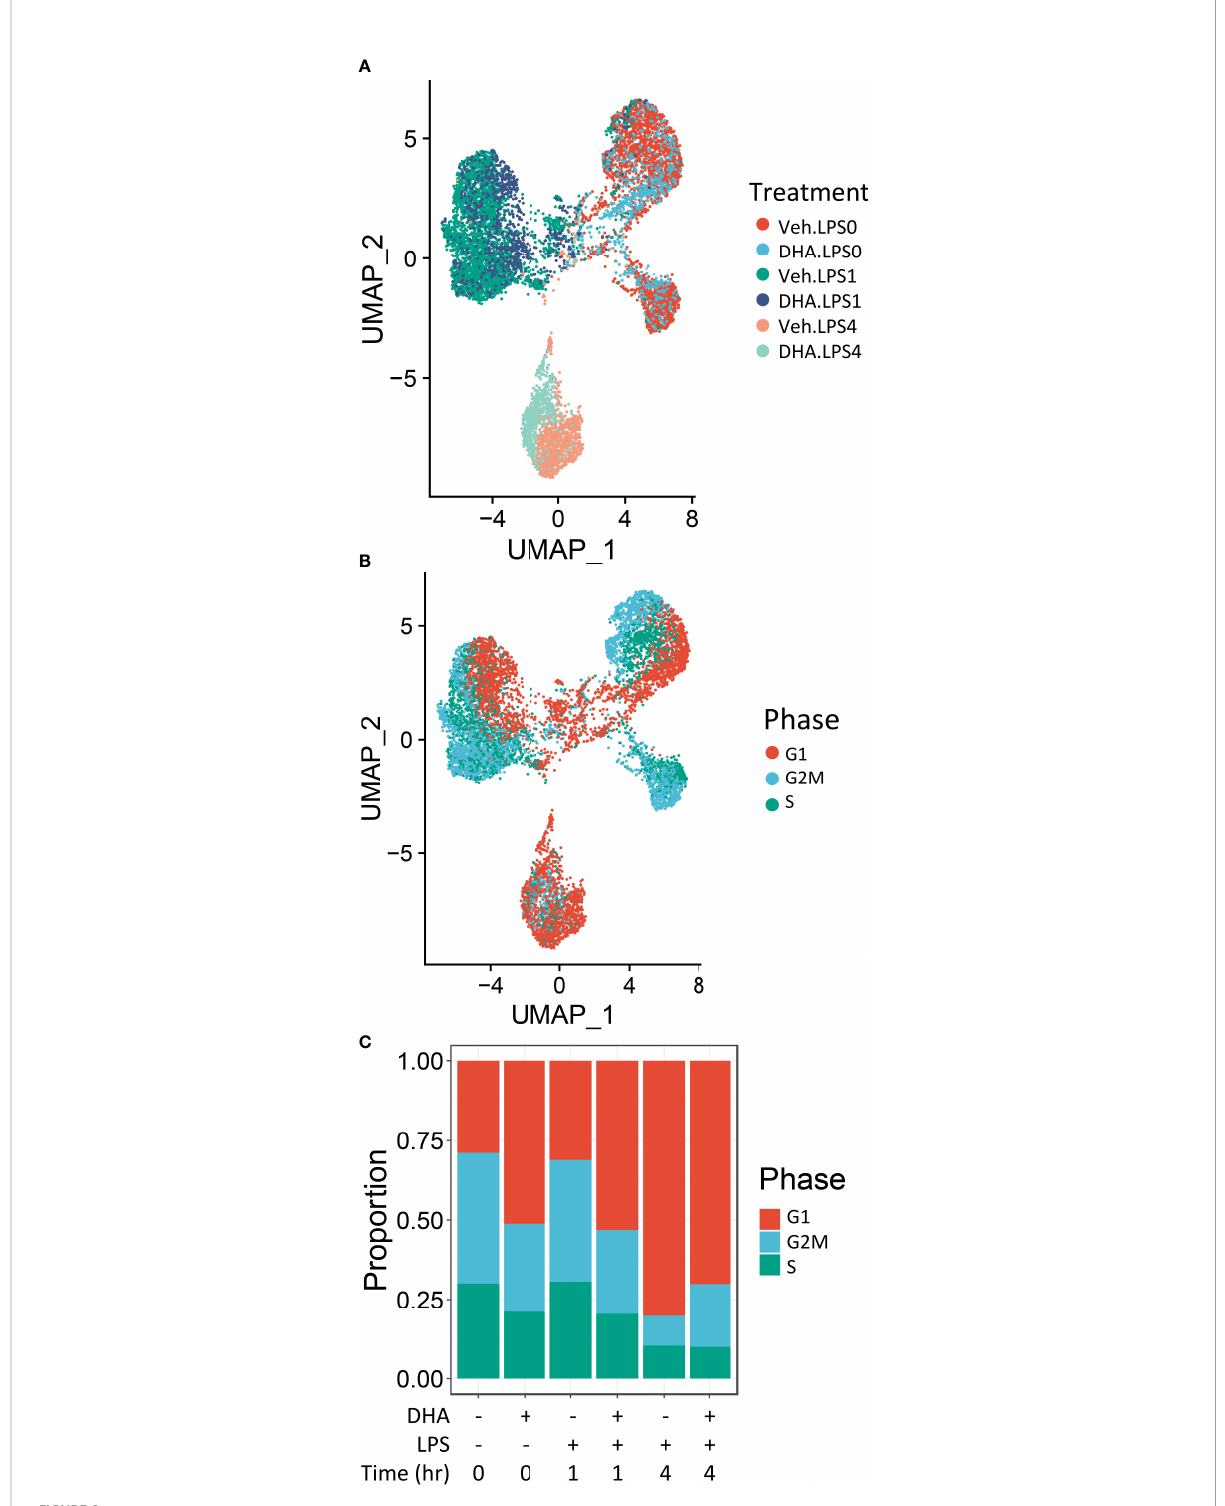
FIGURE 2 Cells cluster according to the presence and duration of LPS treatment. (A) Uniform manifold approximation and projection (UMAP) clustering revealed 3 distinct clusters of cells representing cells that received no LPS treatment cells treated for 1 h, and cells treated for 4h. (B) Distinct subclusters are present for cells in the G1, S and G2 phases of the cell cycle, as identi fi ed by Seurat CellCycleScoring function. (C) Treatment with DHA and with LPS in fl uence the proportion of cells in each phase of the cell